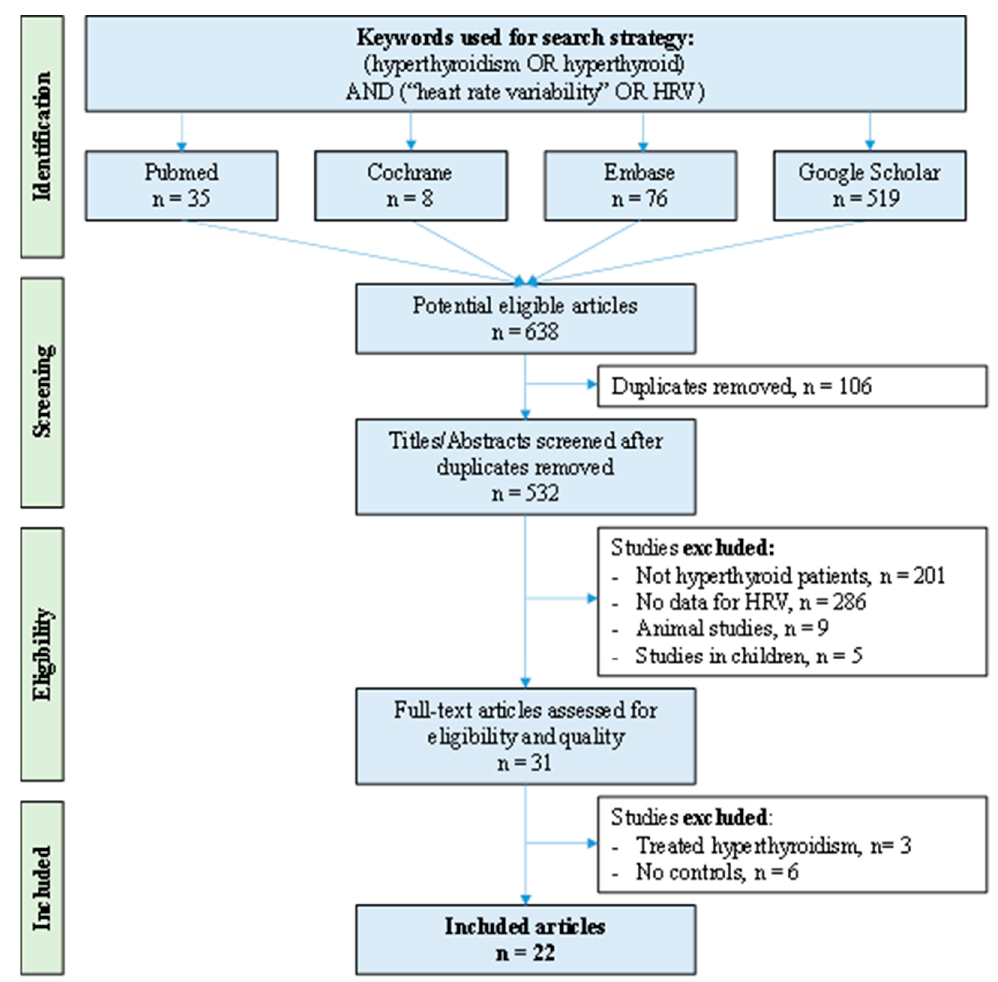
Figure 1. Flow chart. We followed the Preferred Reporting Items for Systematic Reviews and Meta- Analyses (PRISMA) guidelines for the search strategy. HRV: Heart rate